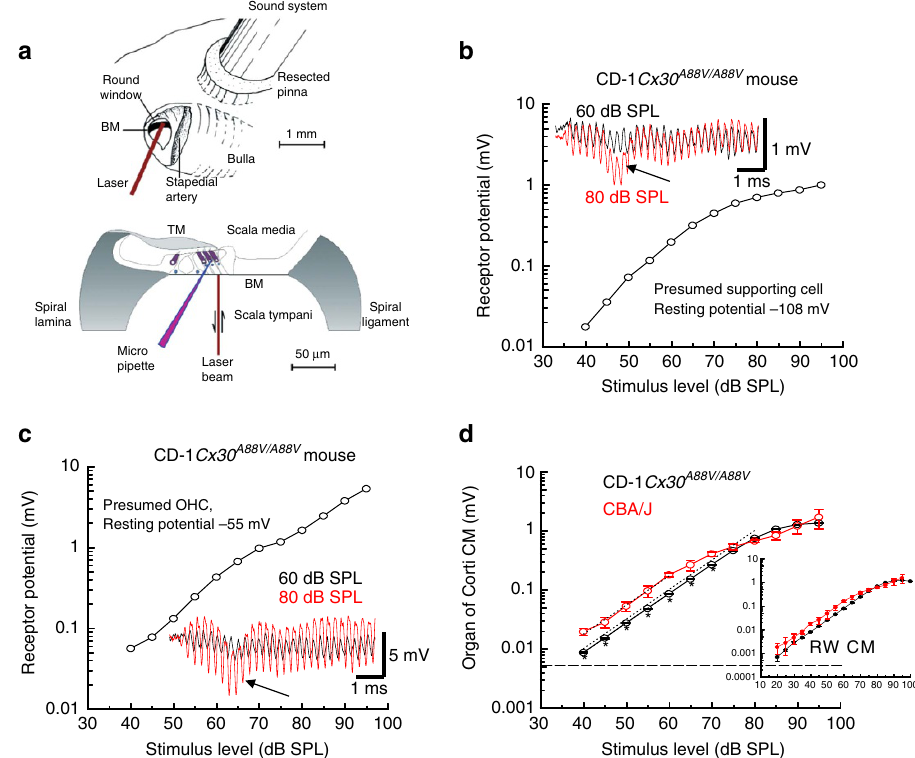
Figure 3 | Magnitude of receptor potential and CM as functions of stimulus level. Recordings from the basal turn cochleae of CD-1 Cx30 A88V/A88V and CBA/J mice in response to 5kHz tones. ( a ) Techniques (in addition to those presented in Fig. 2) used to make acoustic, electrophysiological and mechanical measurements from the cochlea (modified with permission from refs 39,40). ( b ) Peak-to-peak magnitude of an intracellular receptor potential recorded from a presumed supporting cell from a CD-1 Cx30 A88V/A88V mouse in response to a 5kHz tone as a function of stimulus level (representative example). ( c ) Magnitude of an intracellular receptor potential of a presumed OHC of a CD-1 Cx30 A88V/A88V mouse in response to a 5kHz tone as a function of stimulus level (representative example). Insets in b and c show voltage responses to 5kHz tones made at tone onset; stimulus levels: 60dB SPL, black; 80dB SPL, red. Arrows, insets of b and c indicate negative peak of presumed compound action potential. ( d ) Compound extracellular receptor potentials (organ of Corti CM), as functions of stimulus level to 5kHz tones, measured close to the middle row of OHCs (mean ± s.d.) from cochleae of CBA/J (red, n ¼ 5) mice and CD-1 Cx30 A88V/A88V (black, n ¼ 4) mice. Asterisks: significantly different (unpaired t -test, r 0.05 two-tailed p value). Dashed line: recording noise floor for d and inset; CM responses were not seen at any level above this floor for CD-1 Cx30 A88V/WT and CD-1 Cx30 WT/WT mice. Dotted lines: slope of one. Inset, CM recorded from the round windows of the same group of mice (RW